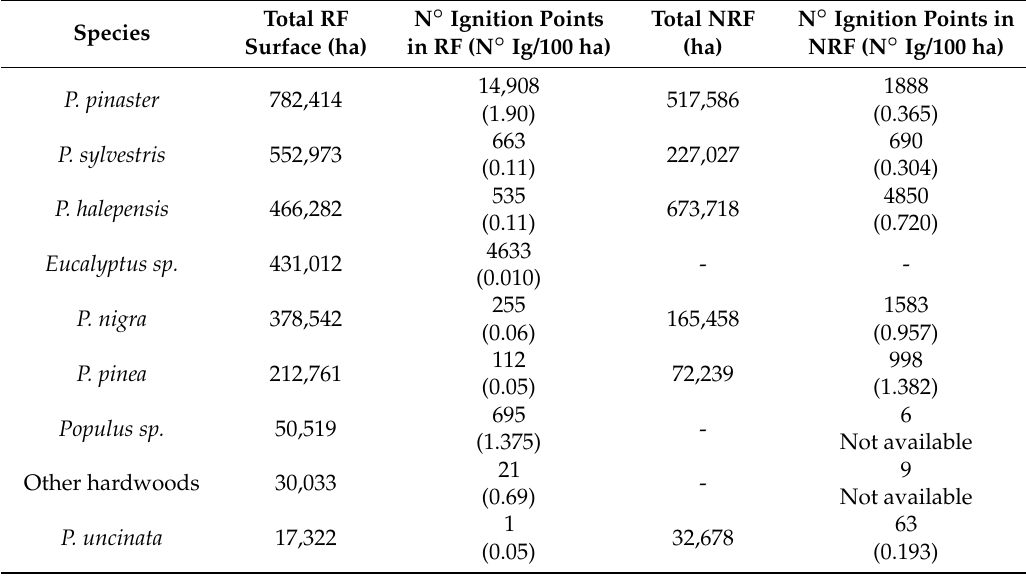
Table 3. Comparison between the number of ignition points located in reforested and natural stand by species (1998–2008) (source: adapted from Castroviejo et al. [52] and the II National Forest Inventory